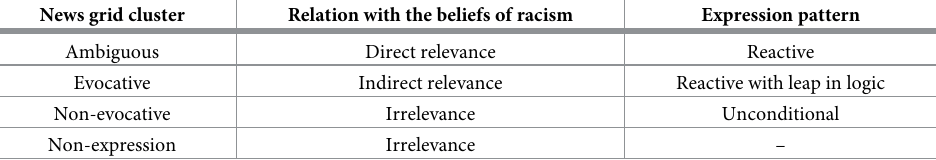
Table 1. Summary of findings. The relationships between news grid clusters and patterns of racial prejudice expres- sions. Derivations of cluster names were as follows. Ambiguous : Which audiences express racial prejudice on what grids were difficult to predict from the characteristics of the audiences and news; Evocative : News grids evoked audi- ences to express racial prejudice due to some characteristics of the contents; and Non-evocative : News grids itself did not evoke audiences to express racial prejudice, but some audiences did so independently of news contents. News grid cluster Relation with the beliefs of racism Expression pattern Ambiguous Direct relevance Reactive Evocative Indirect relevance Reactive with leap in logic Non-evocative Irrelevance Unconditional Non-expression Irrelevance